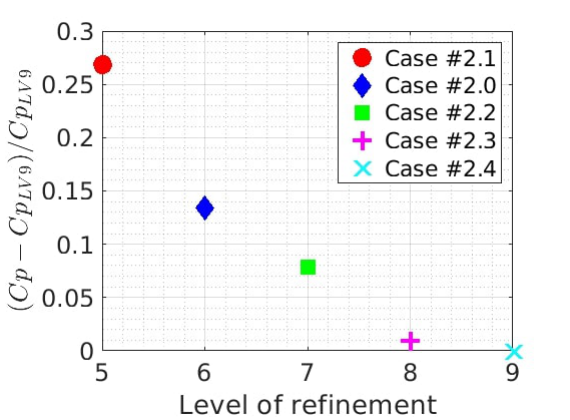
Figure 19. Relative difference between Cp after 1 s of simulation for cases #2.0 (blue lozenge), #2.1 (red dot), #2.2 (green square), #2.3 (pink plus), #2.4 (cyan cross) and #2.4.